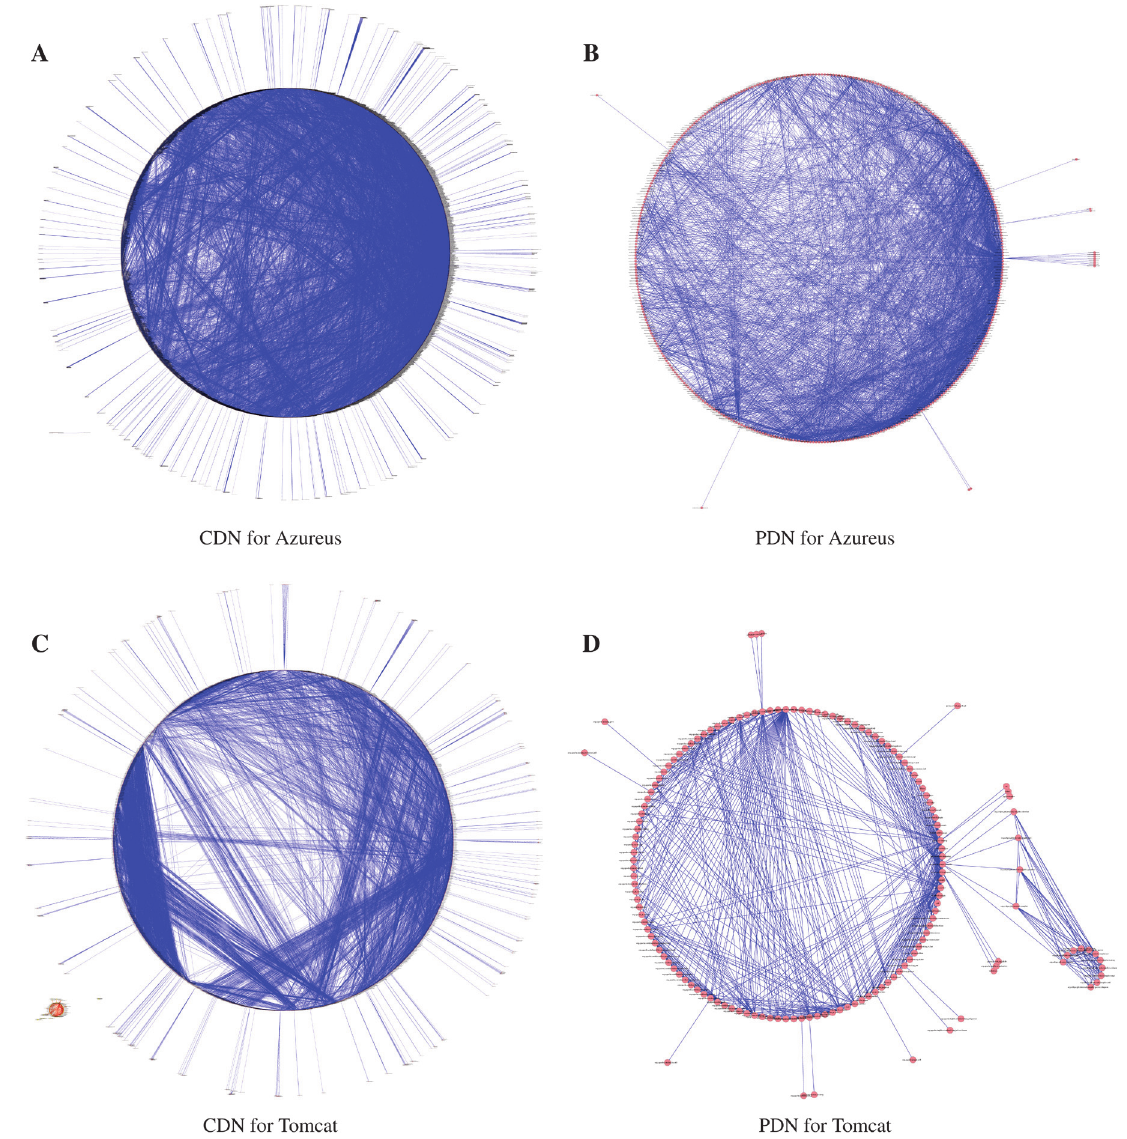
Figure 4. Illustration of the CDNs and PDNs for Azureus and Tomcat.